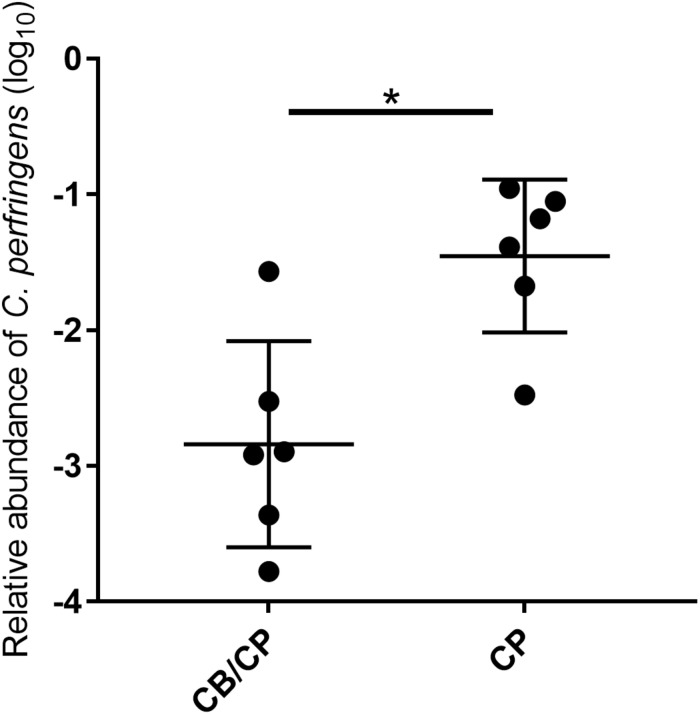
Relative abundance of C. perfringens in the jejunum-ileum lumen post 1-day challenge. All chickens tested negative for C. perfringens until experimentally challenged, and the unchallenged groups tested negative for C. perfringens throughout the study. ∗p < 0.05, measured using ANOVA; n = 6.